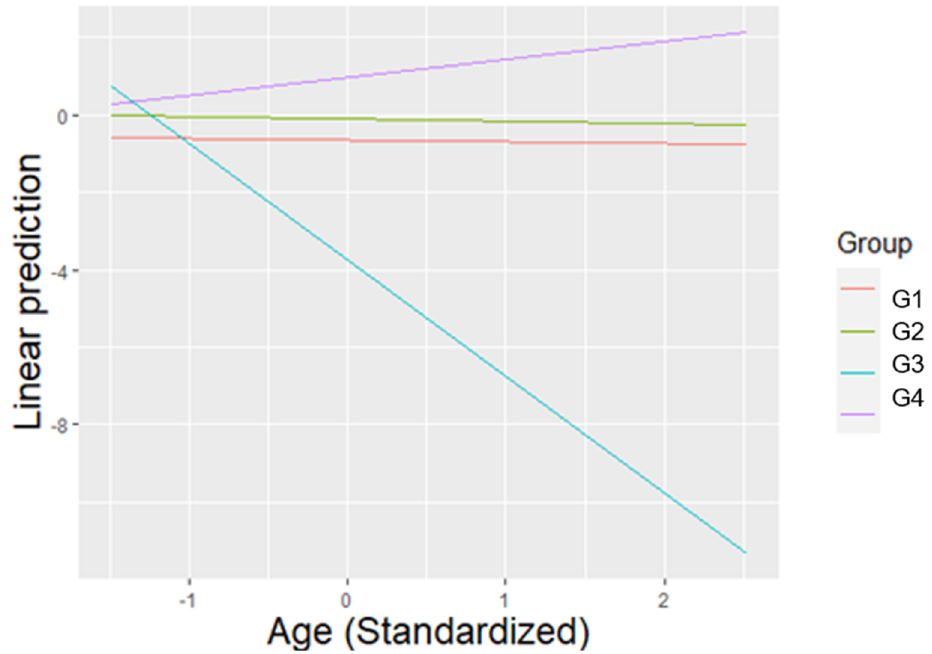
Figure 4. The linear prediction of BCI according to the average value of age (previously standardized), for each group. For the average value of age, Group 3 presented significantly lower behavioural competence compared to all other groups.